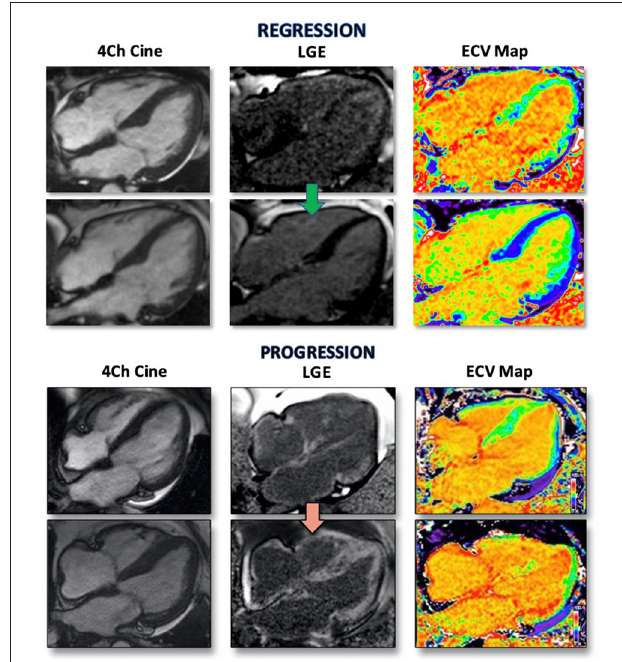
FIGURE 3 | CMR images of two patients with AL CA regression and progression. Four chamber CINE image demonstrating characteristic biventricular thickening (left) with matched LGE images (middle) and ECV maps (right). Top panel is from a patient with a complete hematological response to chemotherapy treatment. Regression of cardiac amyloid is demonstrated by reduction in LV thickness, visualized LGE and normalization of ECV. Bottom panel is from a patient with disease progression reflected by increasing ventricular wall thickness, higher volume LGE and increased ECV